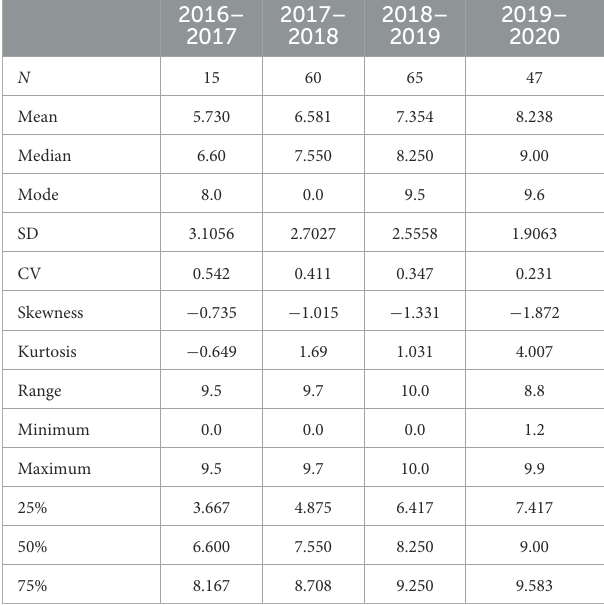
TABLE 2 Descriptive statistics from the data: The number of data (N), mean, median, mode, standard deviation (SD), coefficient of variation (CV), the lack of symmetry (skewness), the difference between the tails weight of the distribution and the tails of a normal distribution (kurtosis), the range, the minimum and maximum values, and the